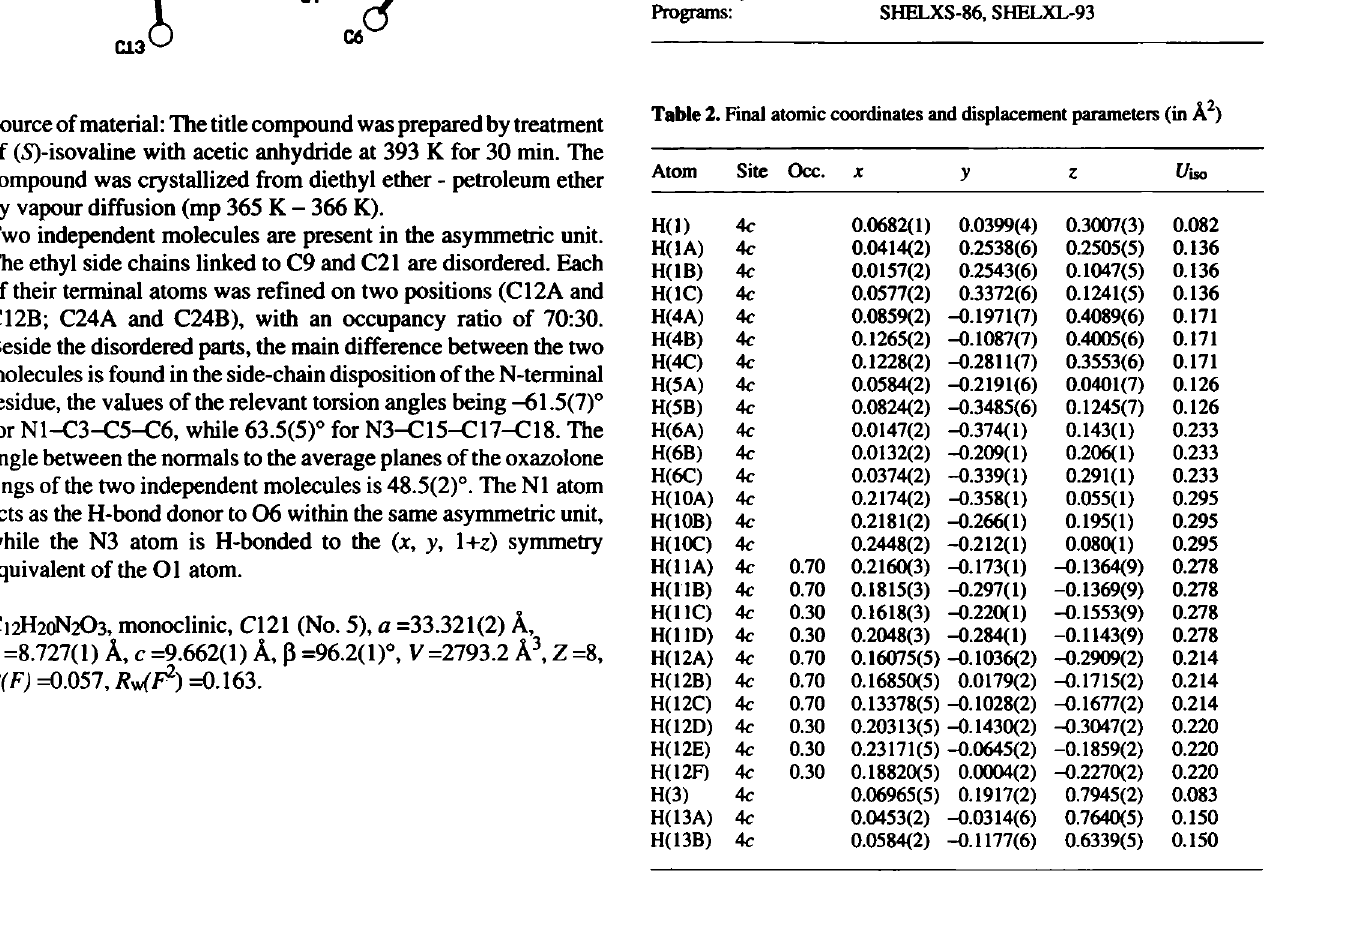
Table 1. Parameters used for the X-ray data collection Crystal: